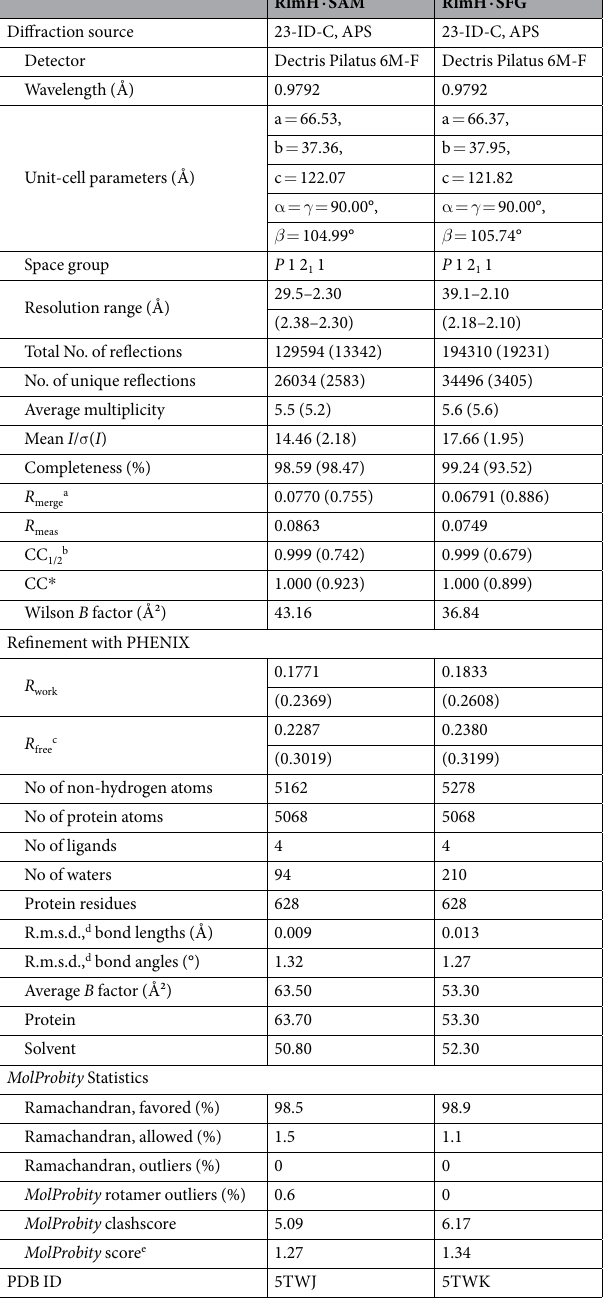
Table 3. Data collection, processing and refinement statistics. Statistics for the highest-resolution shell are shown in parentheses. a R merge and R meas from PHENIX are reported 75 . b CC 1/2 is the correlation coefficient of the mean intensities between two random half-datasets 83 . CC * is an estimate of the “true” CC of the data under examination to the (unknown) true intensities 83 . c 5% of the reflections were selected for free R calculation. d Root-mean-square deviation from ideal values 84 . e MolProbity score was calculated as defined in ref.